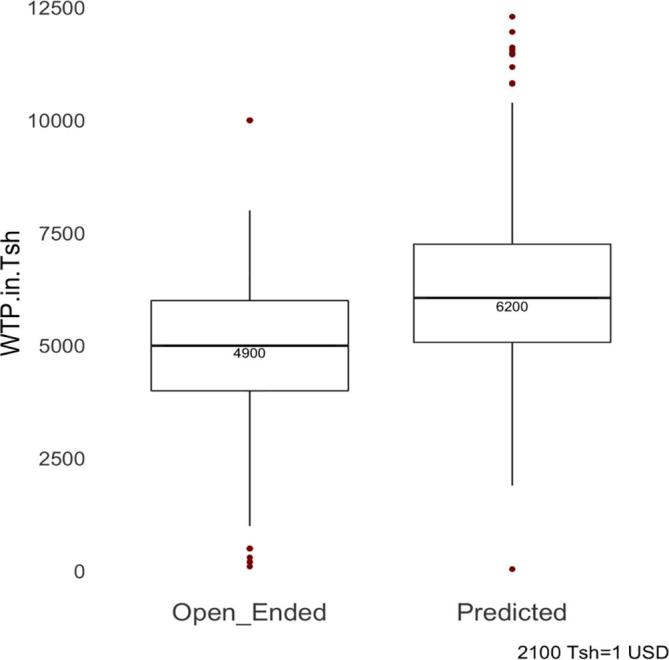
Boxplots of reported household WTP amounts from the open-ended question and the predicted household WTP amounts from the maximum likelihood estimation for diagnostic testing.